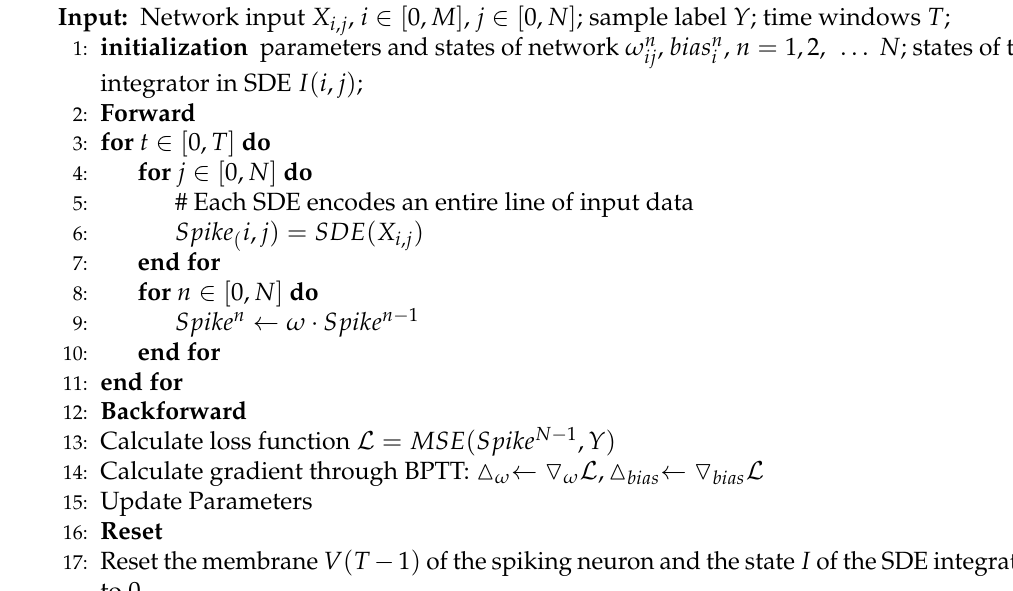
Algorithm 1 Training process of the proposed SNN model and SDE